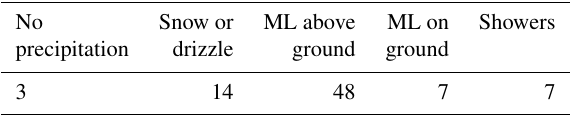
Table 1. Overview of the training cases of 6h